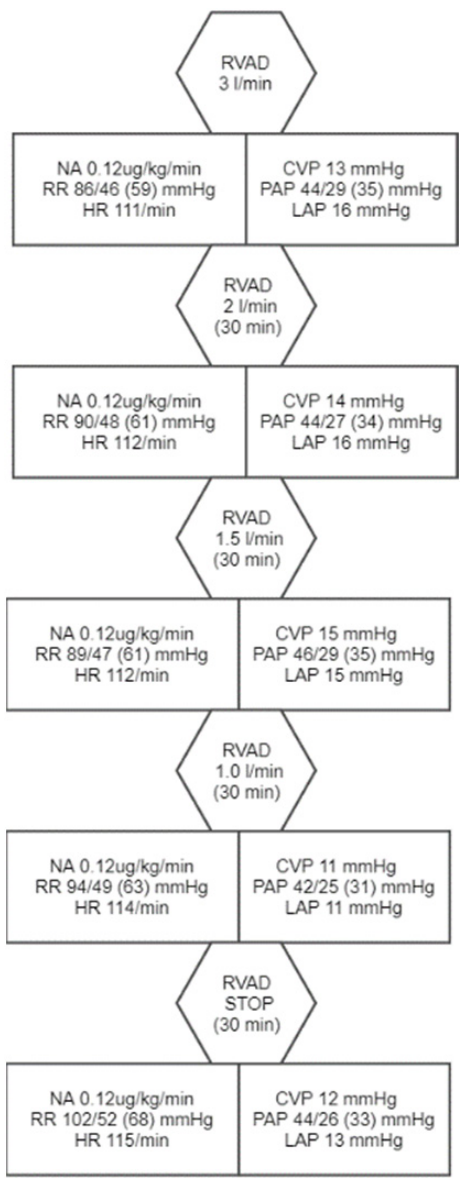
Figure 3. tRVAD weaning protocol with observed vital signs and hemodynamic values. NA—noradrenaline, HR—heart rate, CVP—central venous pressure, PAP—pulmonary arterial pressure, LAP—left atrium pressure.